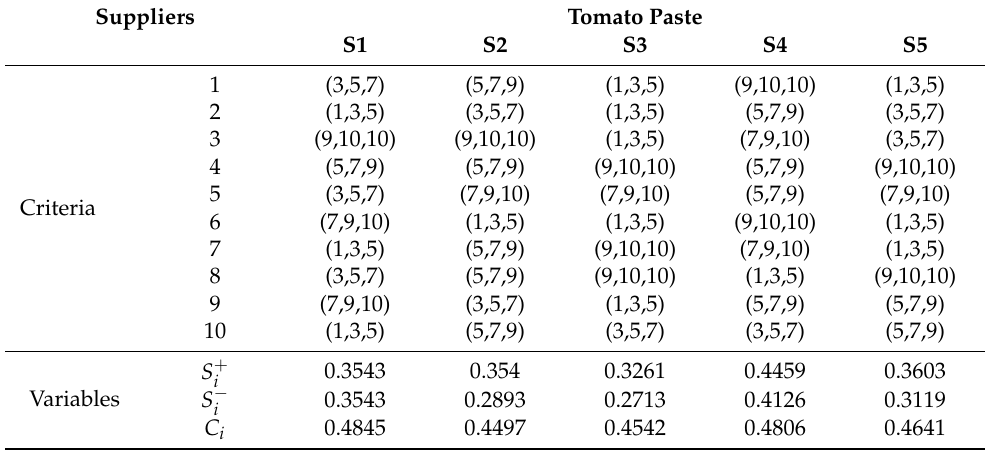
Table A25. Decision matrix considering suppliers and similarity index for tomato paste.